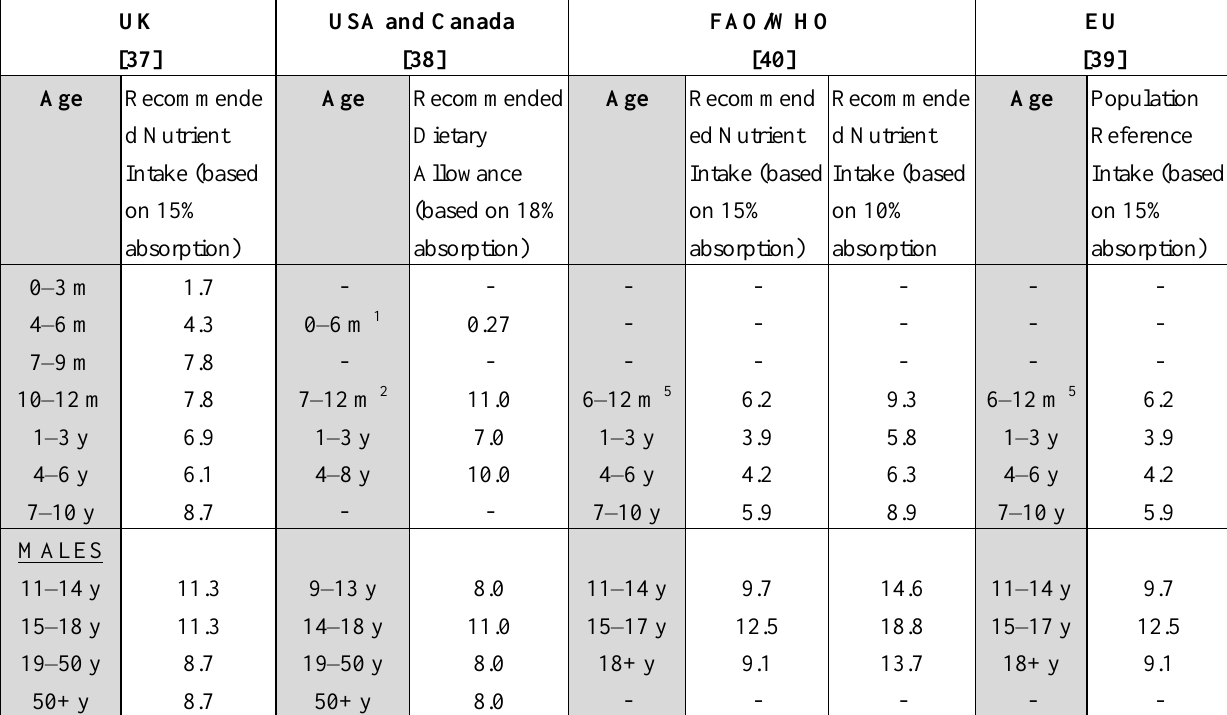
Table 4. International dietary reference values for iron